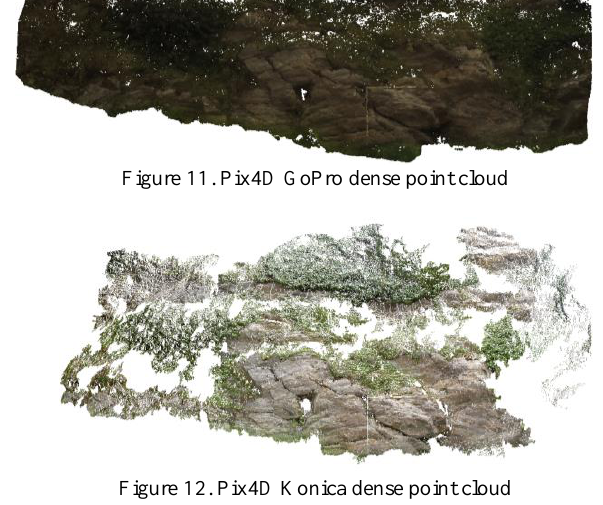
Figure 7. Agisoft PhotoScan Konica dense point cloud